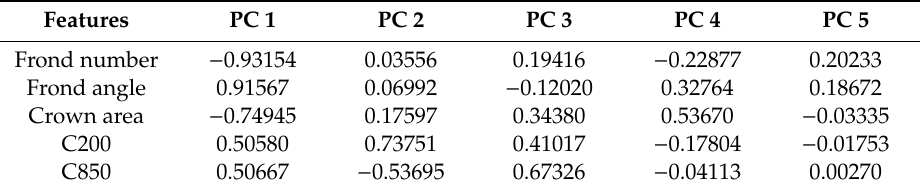
Table 12. Loading matrix of the features on the five significant PCs.